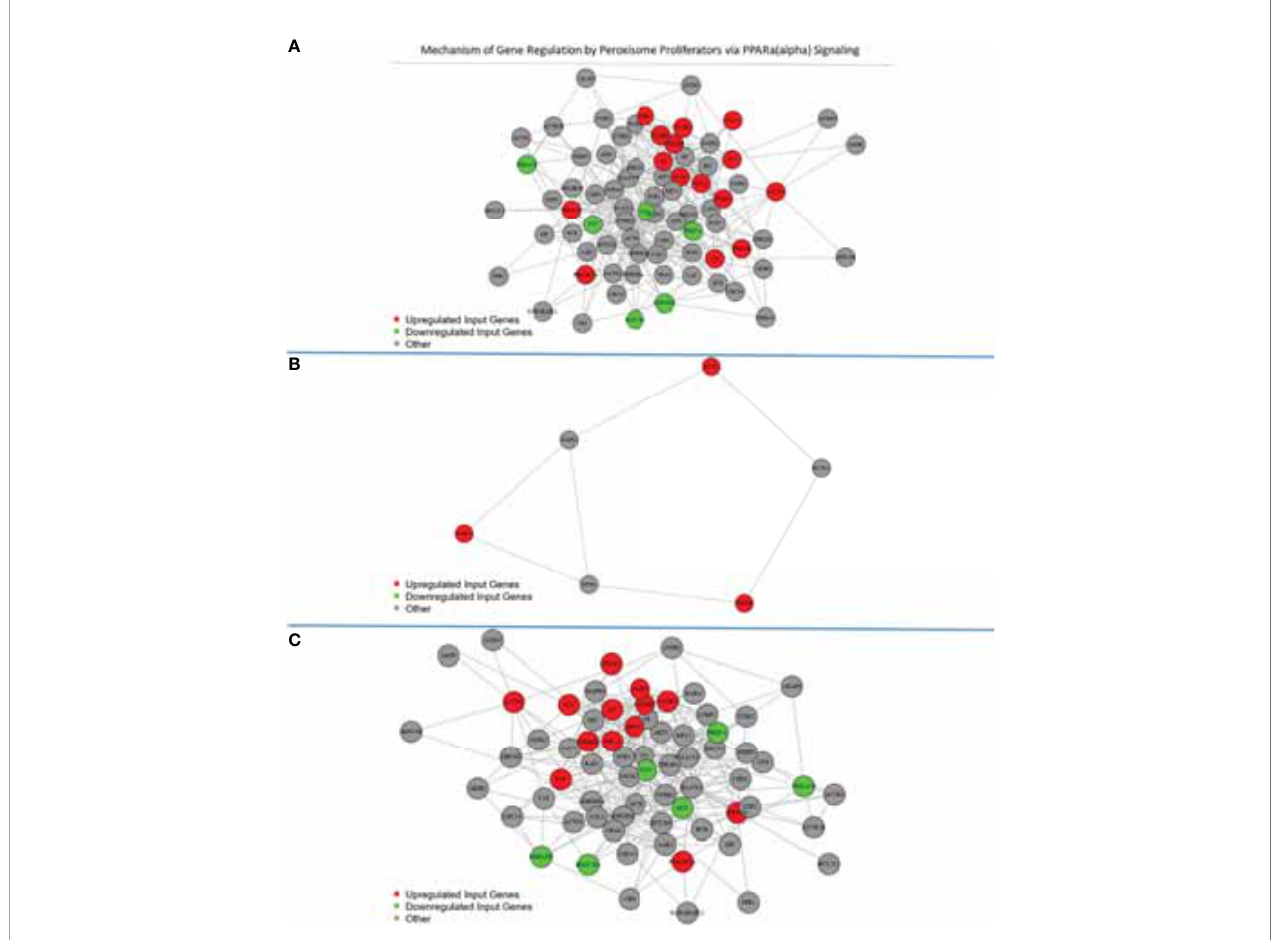
FIGURE 4 | Mechanism of gene regulation by peroxisome proliferators via the PPAR(alpha) pathway: the genes involved in the pathway are reported in red (upregulated) or green (downregulated) for the hemp diet plot (A) and the control diet plot (B) in the time course (T0 and T1) and after a comparison between the two diets plot (C)